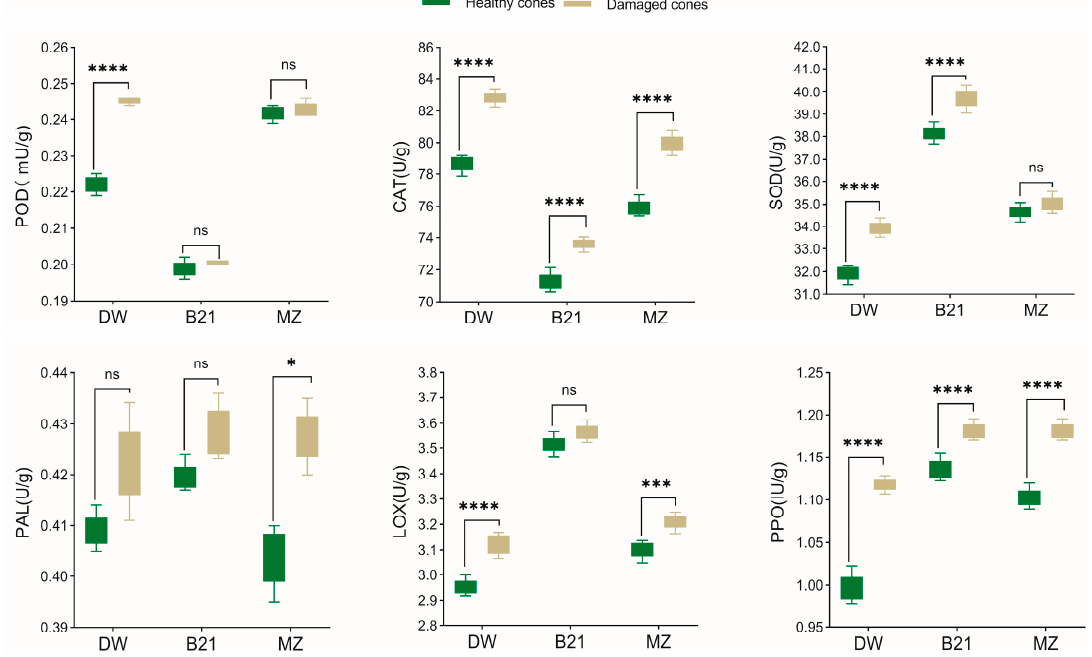
Figure 2. The activities of defense enzymes (Mean ± SE) in the shells of different hazel cultivars before and after chewing by C. nucum . ns p ≥ 0.05, * p < 0.05, *** p < 0.001 and **** p < 0.0001. The ABA and JA contents in the shells of three cultivars were significantly in ‐ creased after C. nucum chewing. Additionally, SA contents of MZ and B21 shells signifi ‐ cantly increased after C. nucum chewing (Table 5, Figure 3).